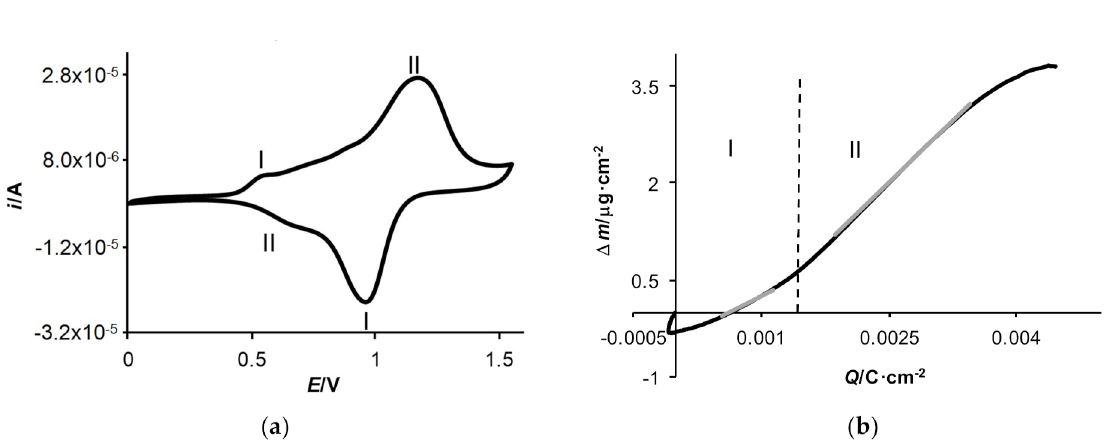
Figure 5. Poly [Ni(salcn)] (1 electropolymerization cycle) in TBAClO 4 /CH 2 Cl 2 , Pt/quarzglas, v = 0.01 V · s − 1 , vs. Ag/AgCl; ( a ) cyclic voltammogram; ( b ) plot ∆ m vs. Q for anodic process; grey parts of the curve—trend lines for the ∆ m = f( Q ) relationship. I and II—peaks labels.